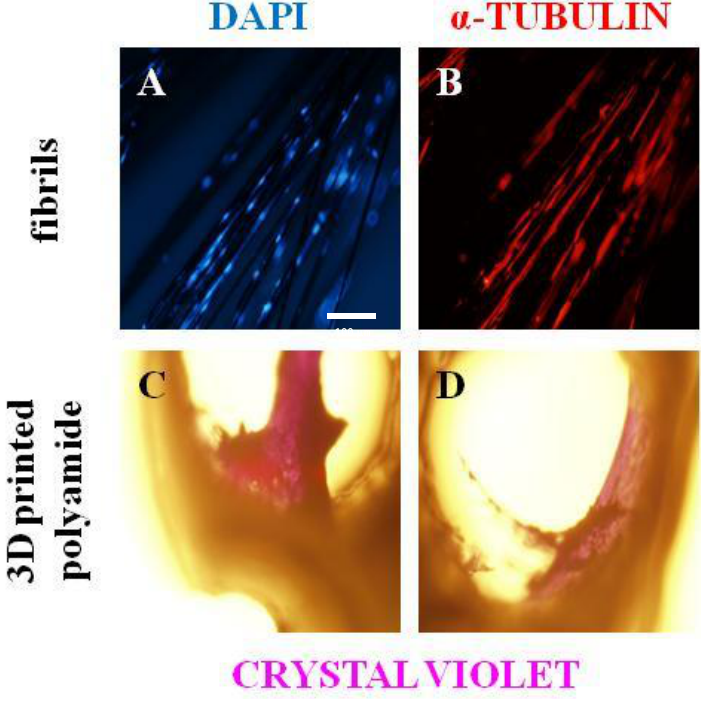
Figure 4. hMSC adhesion on 3D fabric polyamide–carbon fibril composite. ( A ) Fluorescence detection of hMSCs’ nuclei with DAPI. ( B ) Immunofluorescence determination with α-tubulin. Scale bar represents 100 µm. ( C , D ) hMSCs micro-masses dyed with crystal violet on 3D-printed polyamide.